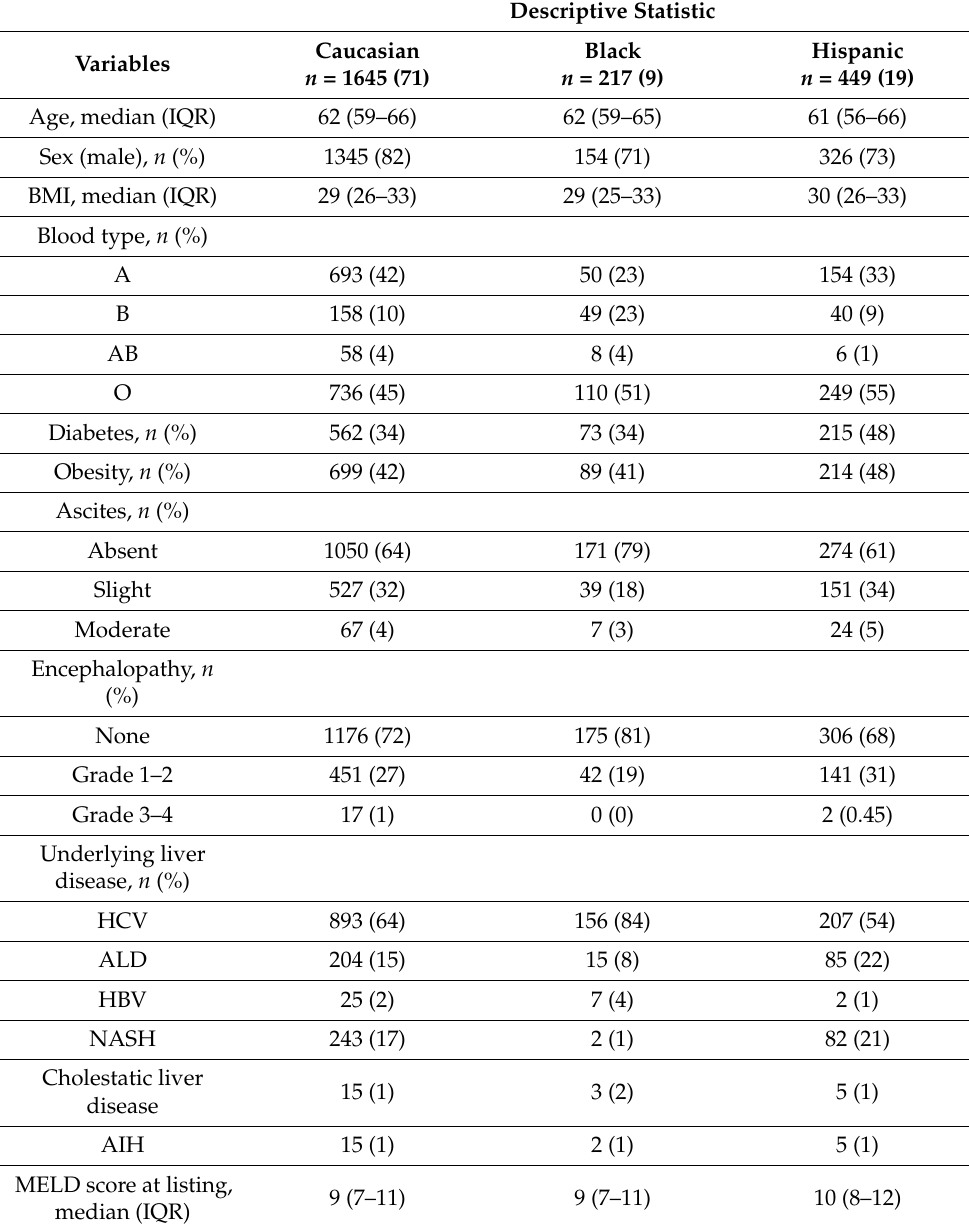
Table 1. Baseline demographic and clinical characteristics of patients diagnosed with HCC who had exception points from 2015 to 2019, grouped according to ethnicity ( n =